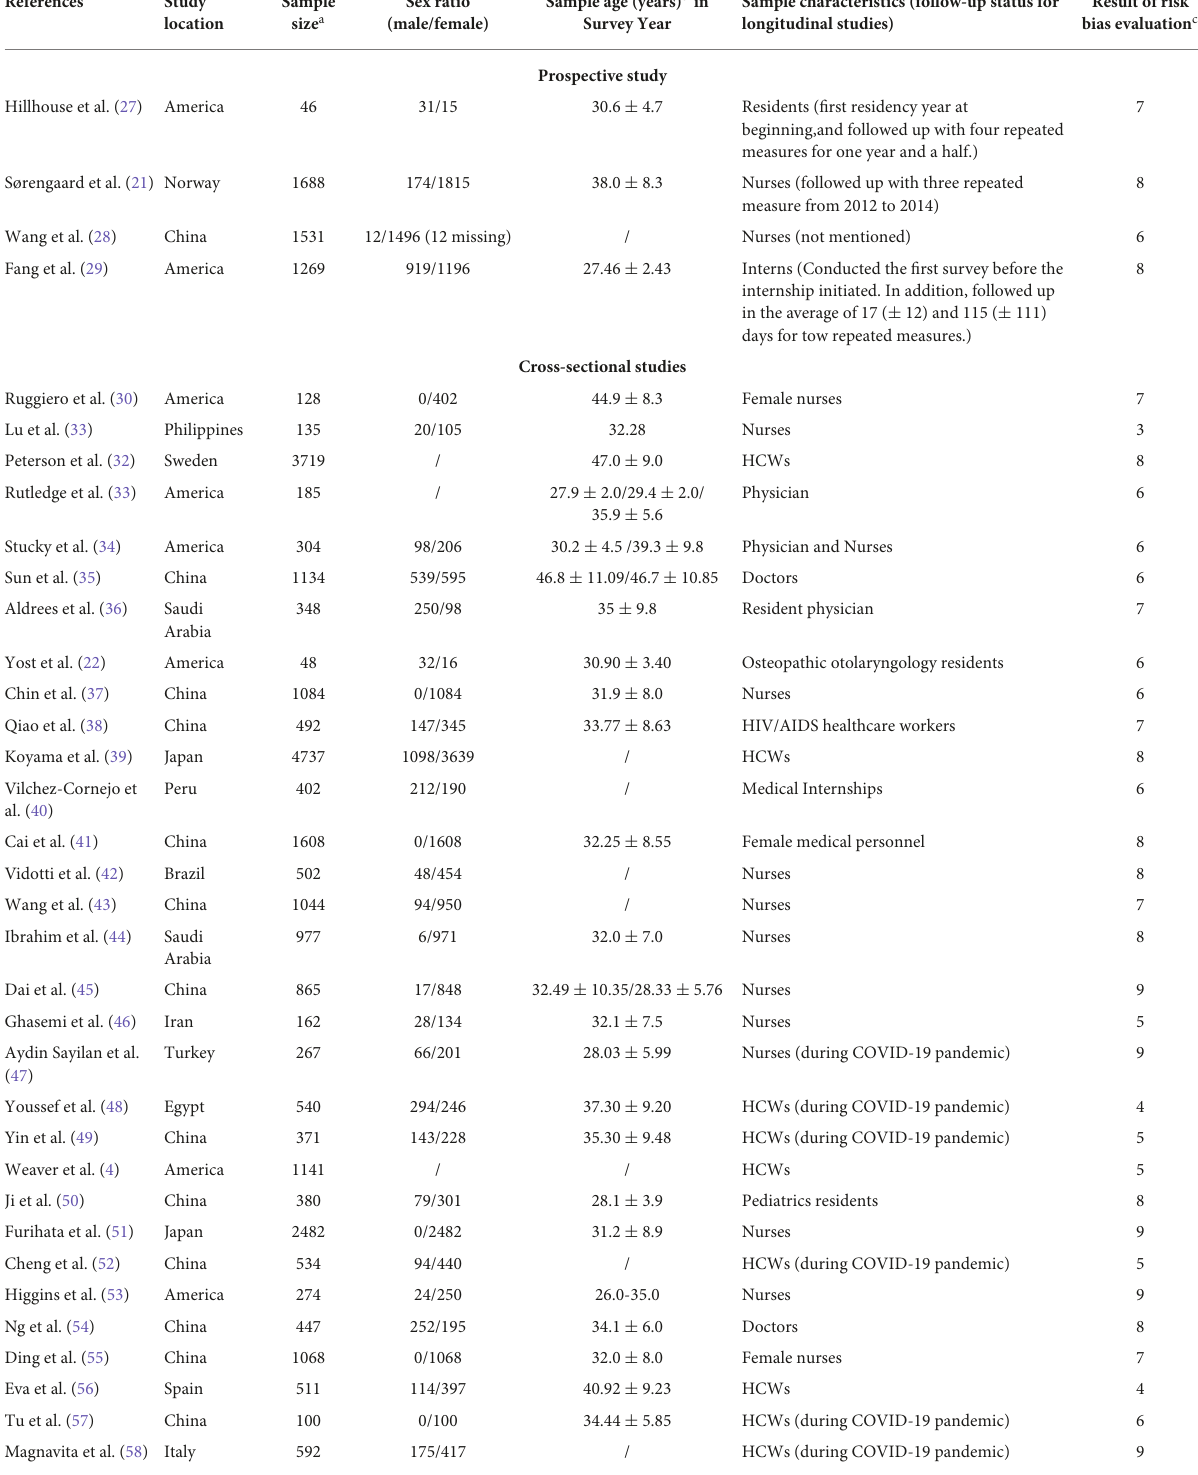
TABLE 1 Characteristics of all studies included in this study ( n =